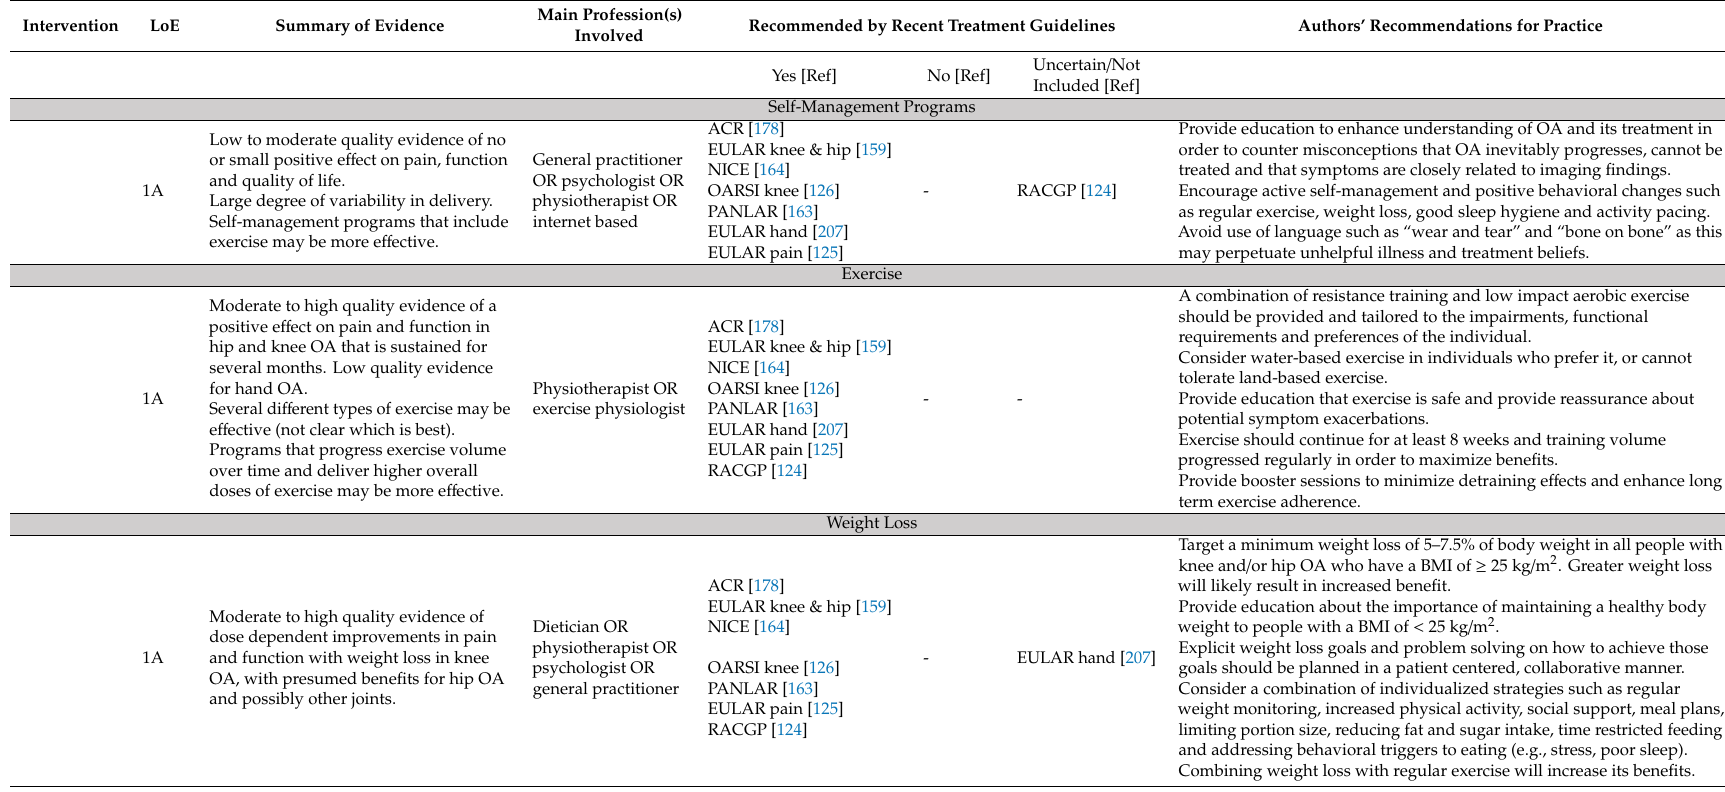
Table 1. Best evidence table for the rehabilitation of people with osteoarthritis: Summary of the evidence and recommendations for practice. Intervention